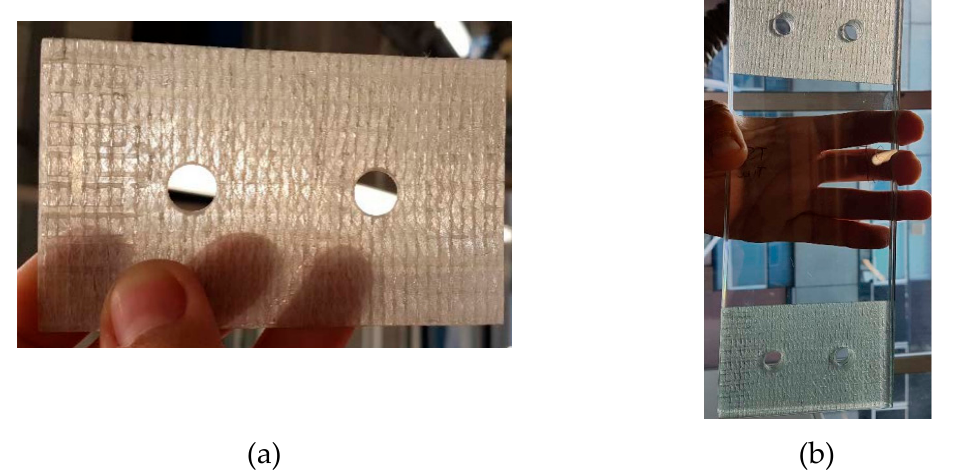
Figure 13. Examples of ( a ) GFRP strips (detail view) for ( b ) GFRP-reinforced bolted connections in structural glass members (reproduced from [84]).